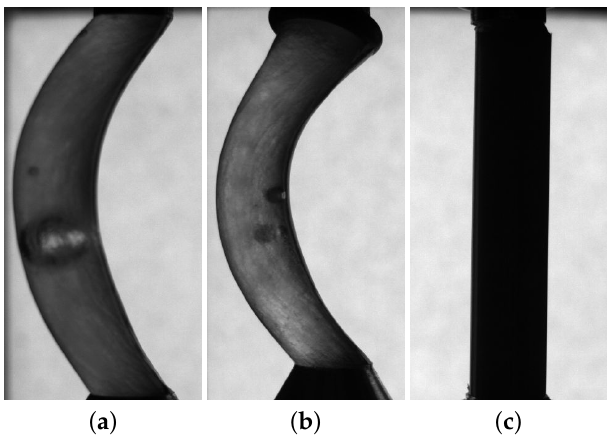
Figure 6. Smectic bridges during the deceleration phase: ST00552 in SmC at 44 ◦ C ( a ) and in SmA at 53 ◦ C ( b ). The inertia pulls the middle of the columns in a direction perpendicular to their axes. ( c ) shows the columnar material in the M2 phase at the same instant and acceleration. The aspect ratios are α = 4.6 ( b ) and 4.75 ( a , c ). The image sizes are 8 mm × 16